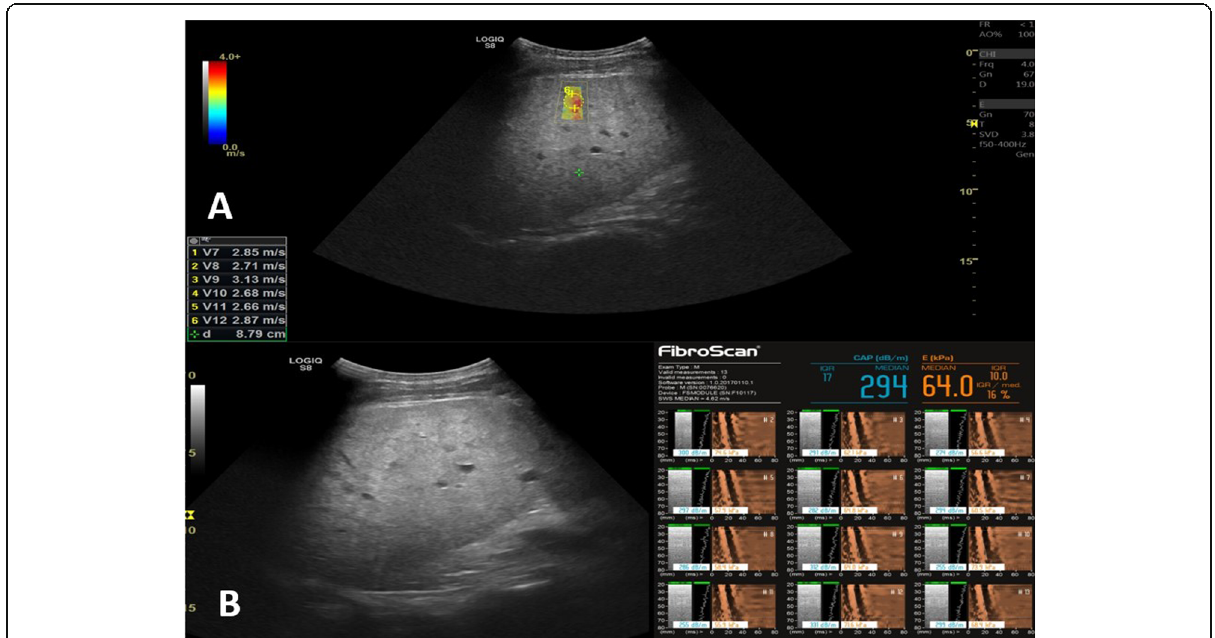
Fig. 4 A male patient 52 years old with chronic hepatitis C infection on follow-up. a SWE revealed median velocity = 2.62 m/s and V median/IQR = 14.6% consistent with F4 according to Metavir score. b Fibroscan was done for the same patient and revealed kPa = 64 and IQR/median = 16% consistent with F4